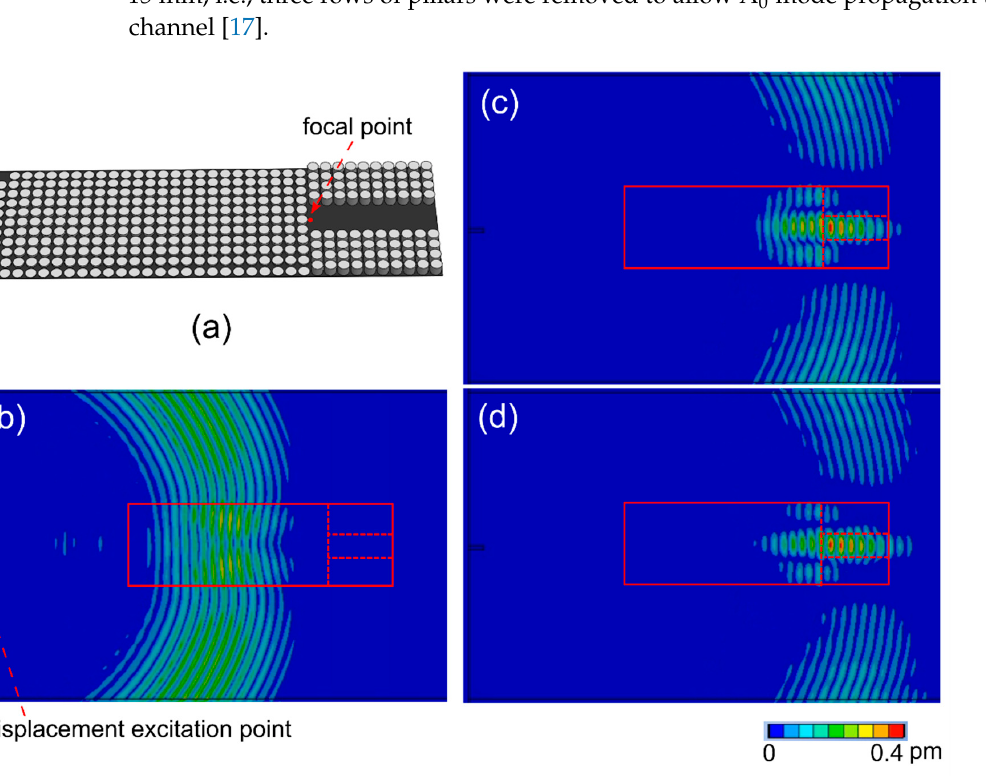
Figure 6. ( a ) Schematic of the GRIN structure with the waveguide channel. Simulated out-of-plane displacement field on the opposite surface of the aluminum plate ( b ) at 208 µs, ( c ) at 283 µs, and ( d ) at 293 µs. Red box shows the location of the GRIN lens and channel, separated by a dashed